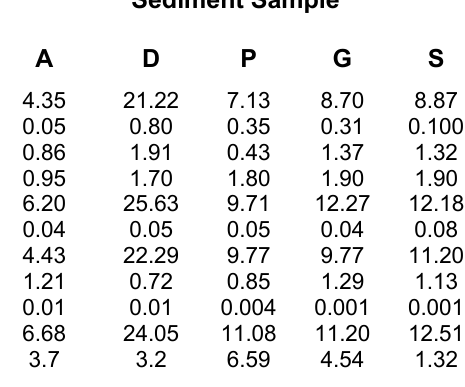
The Soluble Cations and Anions of the Marine Sediment Samples